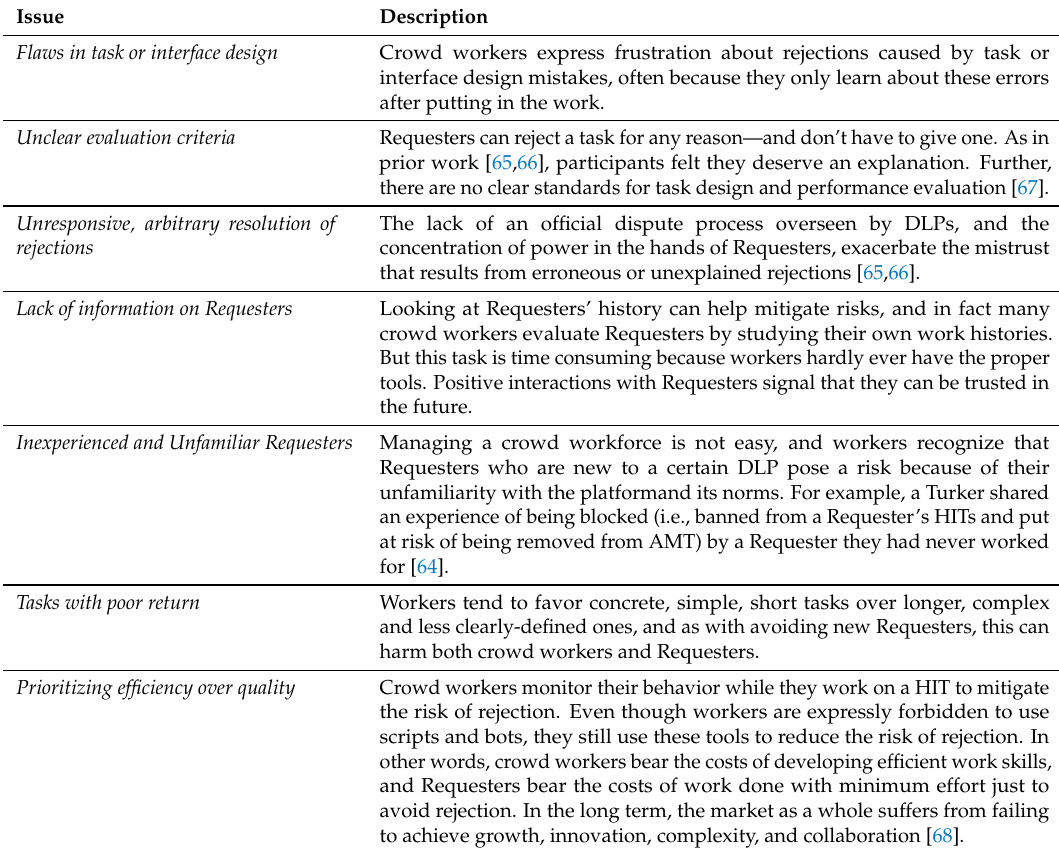
Figure 6. The GigAdvisor “My Contracts” functionality. User can browse its contracts ( a ), and rate the DLPs he worked for ( b ). Table 1. Main issues for crowd workers dealing with DLPs: a taxonomy from